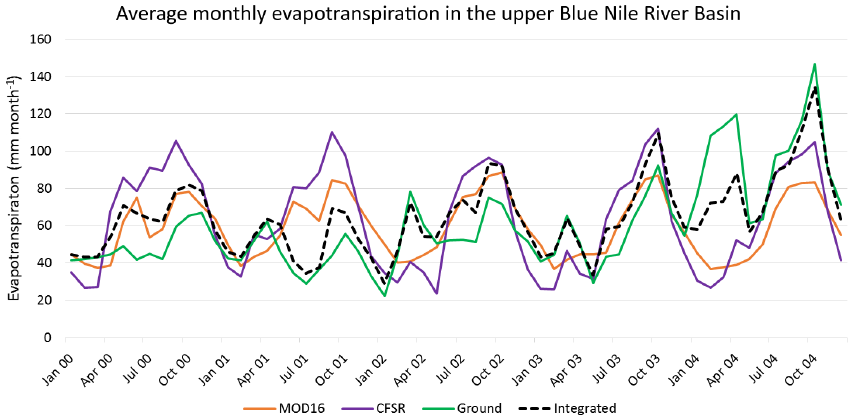
Figure 12. Average monthly evapotranspiration analysis using SWAT87 and the Penman–Monteith method, with R 2 and NS values of the integrated dataset: 0.36, − 0.02; ground dataset: 0.34, − 0.10; and CFSR dataset: 0.74, 0.03, respectively, compared to the MOD16